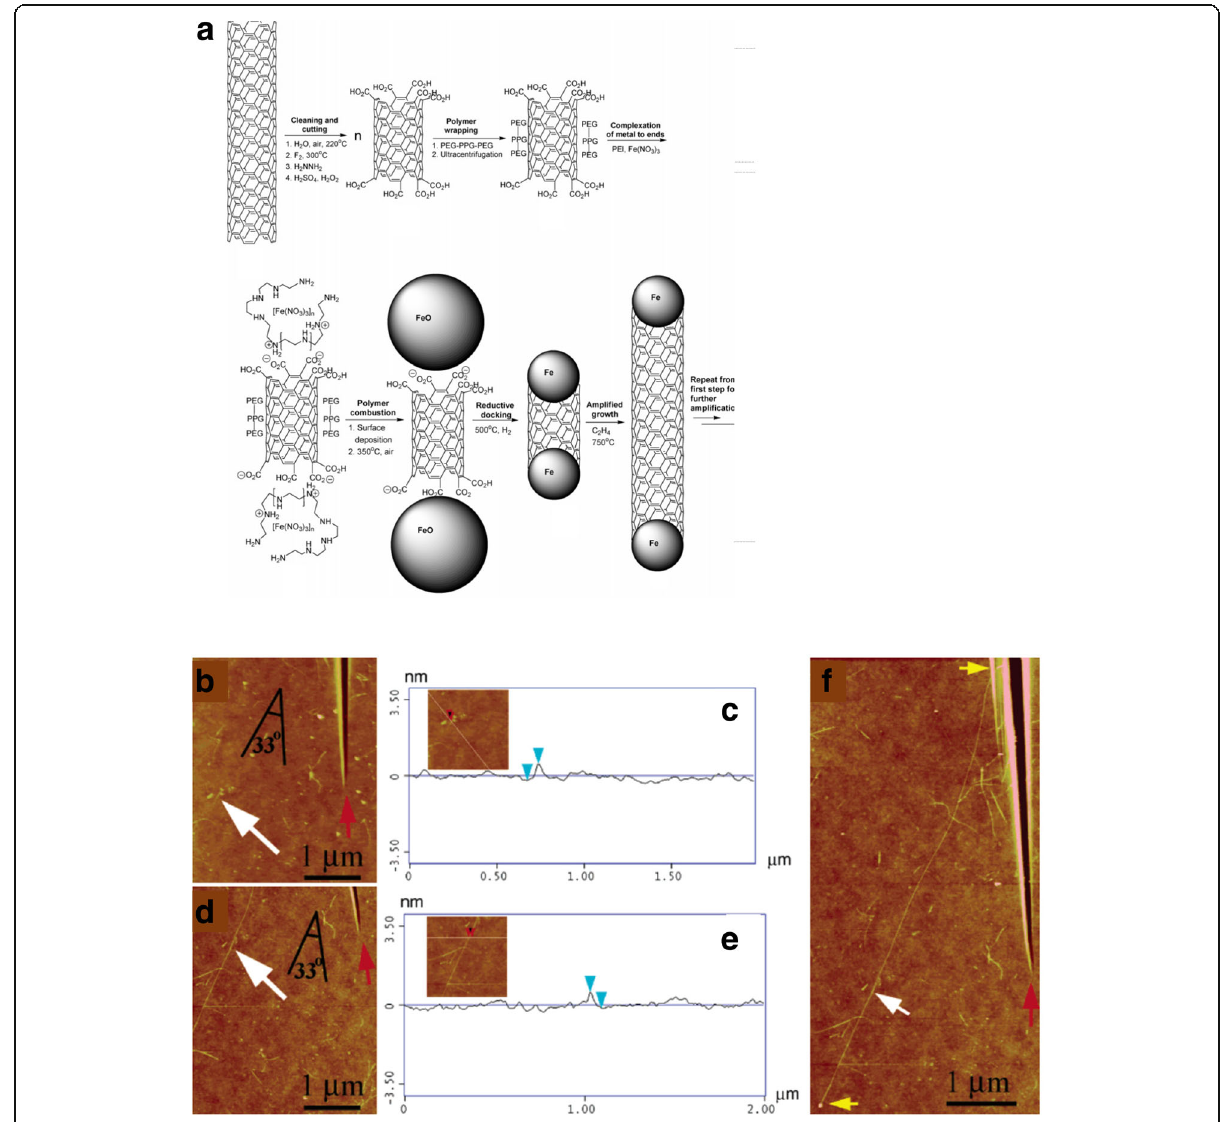
Fig. 9 a Growth mechanism of SWCNTs using Fe seeds as growth templates. Adapted from [116]. b , c Atomic force microscope (AFM) images and height analysis of SWCNTs before the amplification process. Adapted from [116] and d , f after amplification growth process. Adapted from [116]. White arrows represent the original SWCNT seed location, red arrow indicates the seed position and angle relative to the locator inscription and yellow arrows show the entire length of the amplified nanotube. Adapted from